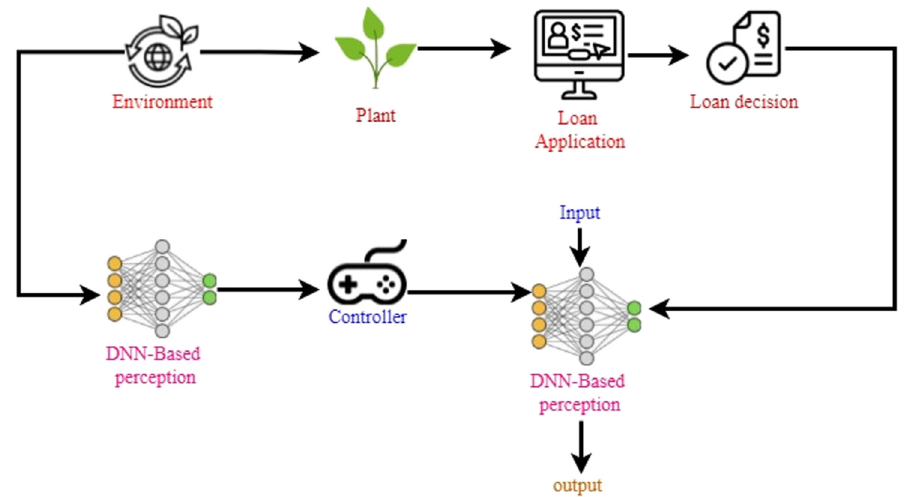
Figure 6: Environmental of deep neural